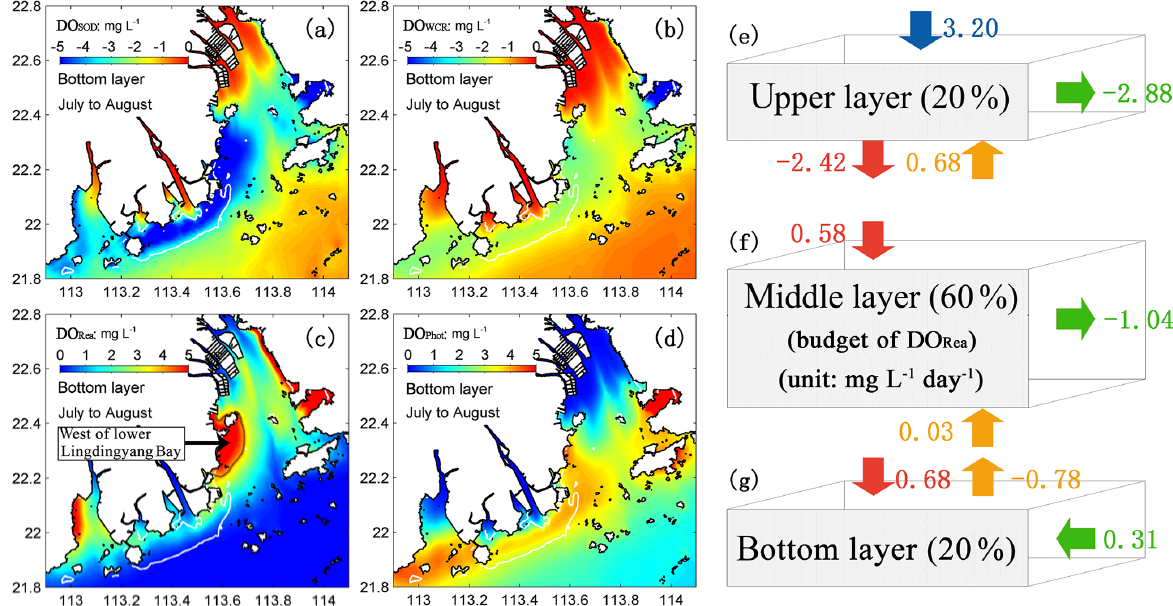
Figure 14. Spatial distributions of the monthly averaged (a) DO SOD , (b) DO WCR , (c) DO Rea , and (d) DO Phot at the bottom layer. Note that the HFZ is also shown here (denoted by the area encompassed by white lines). The DO Rea balance analysis for (e) the upper layer, (f) the middle layer, and (g ) the bottom layer to the west of the lower Lingdingyang Bay (the western shoal near Qi’ao Island and encompassed by a DO Rea isoline of 4mgL − 1 ; as shown in c ). Blue arrows represent the re-aeration rates; red arrows represent the vertical diffusive fluxes of DO Rea ; orange arrows represent the vertical advective fluxes of DO Rea ; green arrows represent the horizontal advective fluxes of DO Rea . Note that positive values indicate sources of DO, while negative values indicate sinks of DO (unit: mgL − 1 day − 1 )